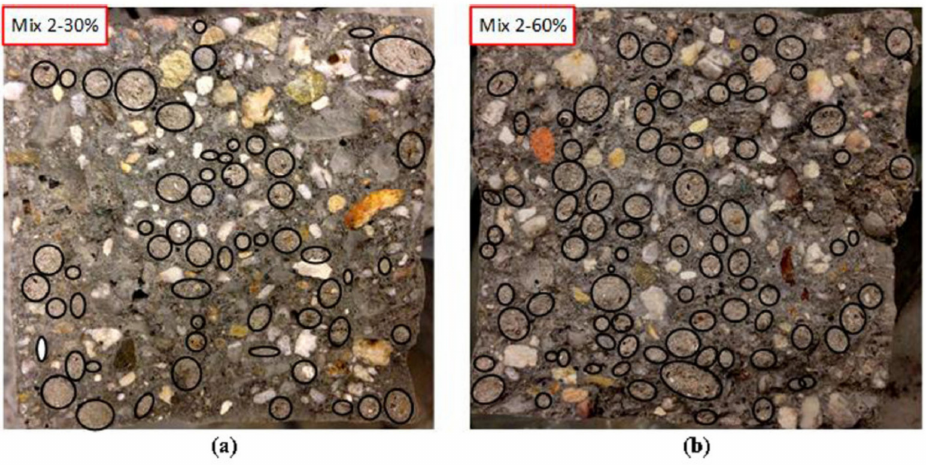
Figure 13. The cross-section of the concrete cube with ( a ) 30% and ( b ) 60% vol. aggregate replacement [114], with copyright permission from